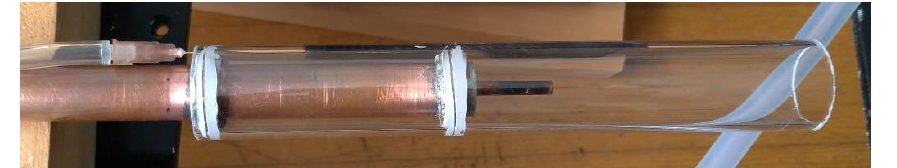
Figure 2. Image of the quartz channel for particle